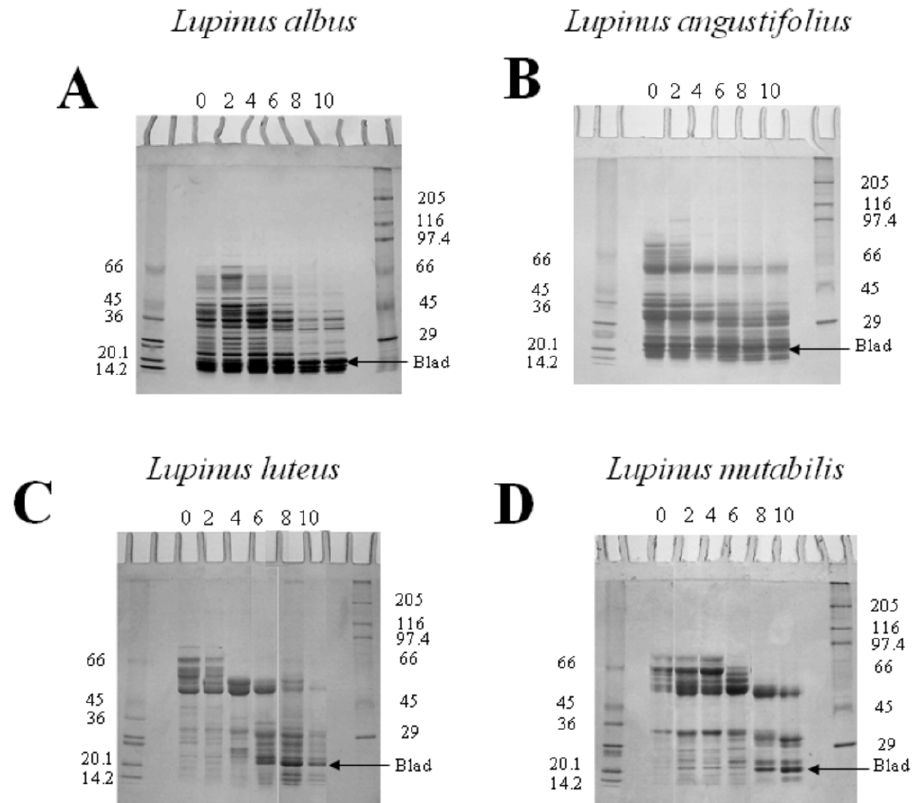
Figure 2. One-dimensional, structural analysis of b -conglutin from Lupinusalbus , Lupinsangustifolius , Lupinusluteus and Lupinus mutabilis . L. albus (A), L. angustifolius (B), L. luteus (C) and L. mutabilis (D) seeds were germinated for up to 10 days, and b -conglutin extracted, purified, analysed by one-dimensional SDS-PAGE and stained for total protein. Seeds were germinated for the number of days indicated on top of the gels. Fifty m g of protein were loaded in each lane. Molecular masses of standards are indicated in